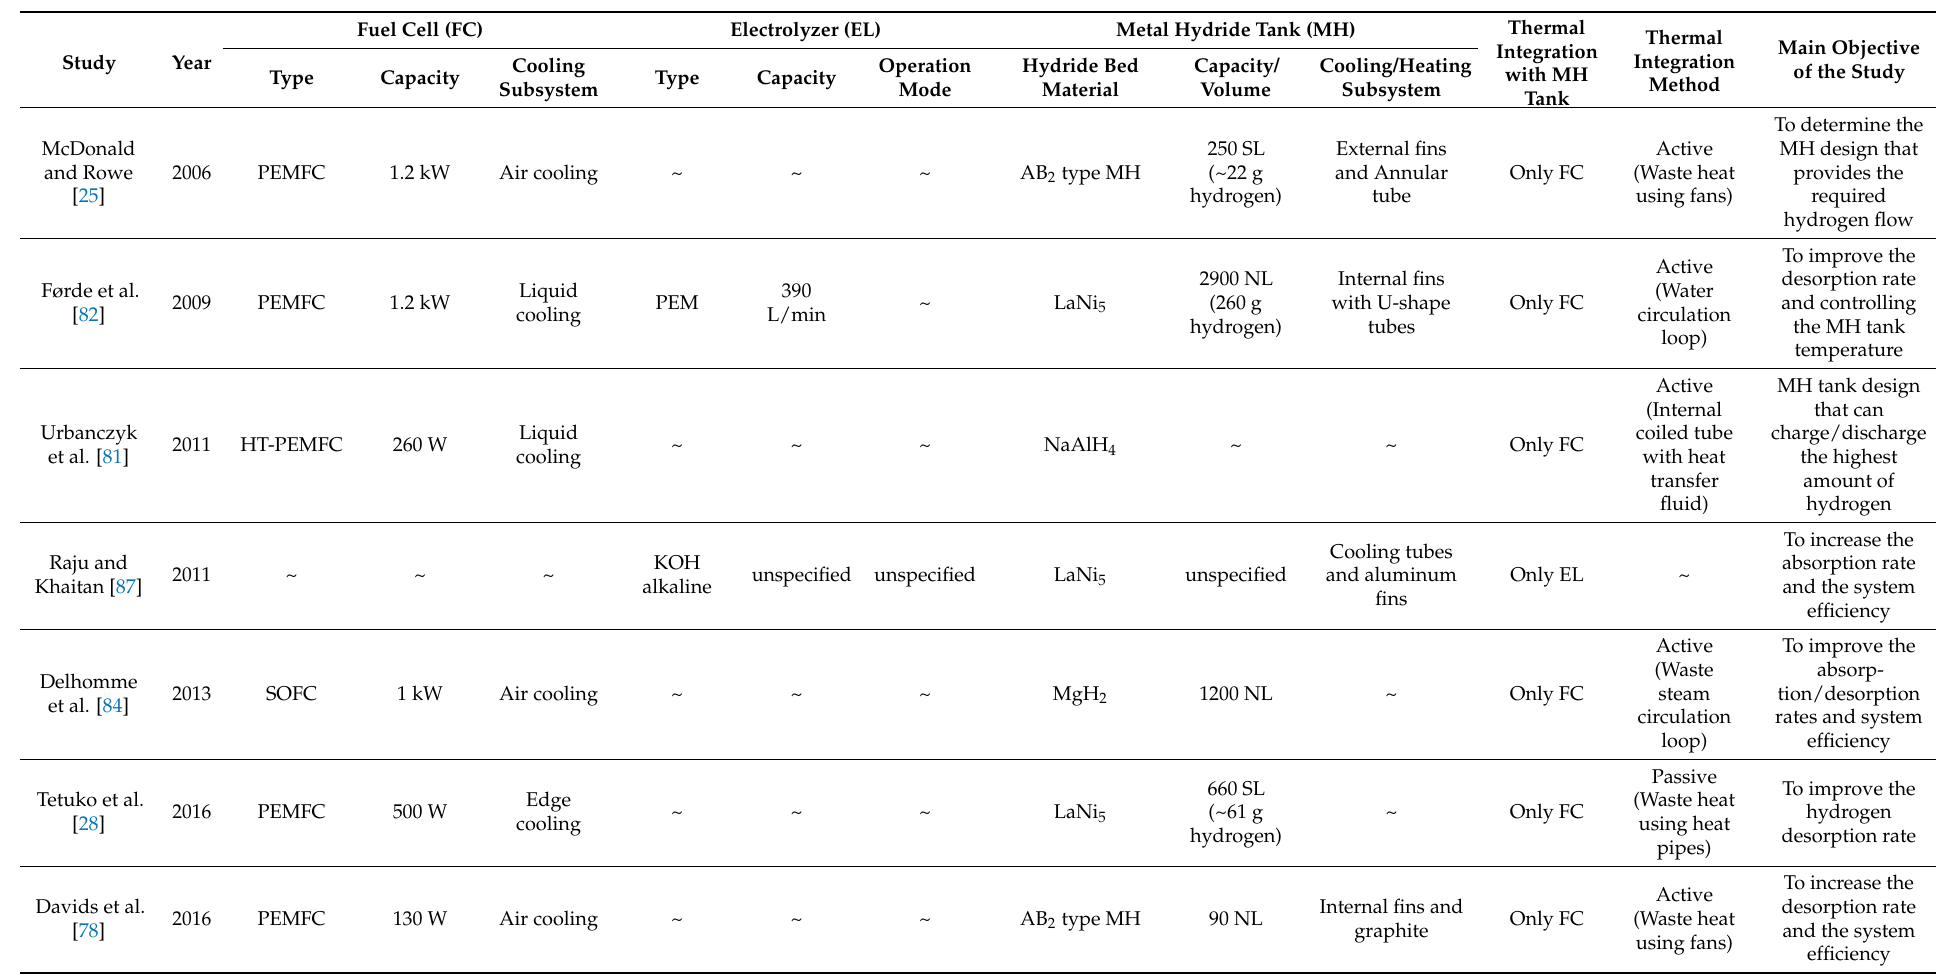
Table 3. Thermal integration methods for fuel cell and/or electrolyzer systems with MH